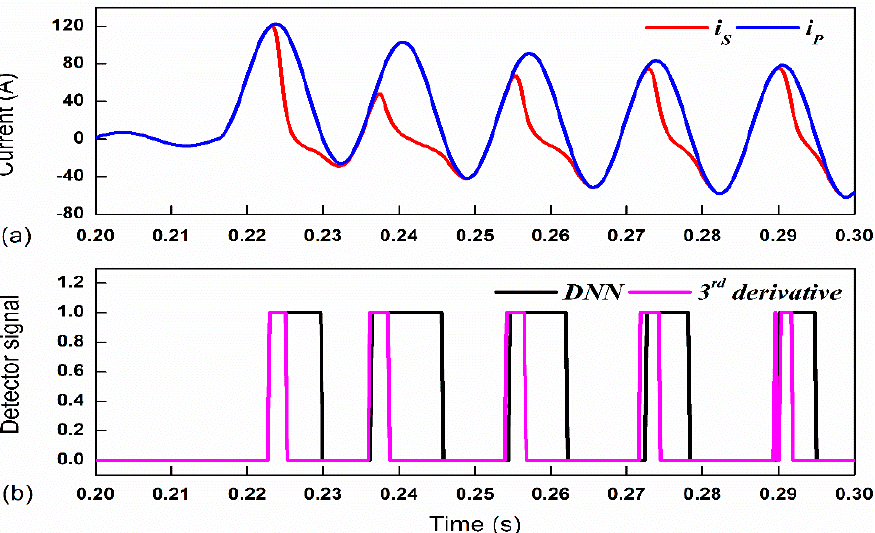
Figure 9. The detection result of CT saturation on the 345-kV (FIA of 0 0 , and remnant flux of 80%). ( a ) Saturated and non-saturated waveform; ( b ) Detection signals.